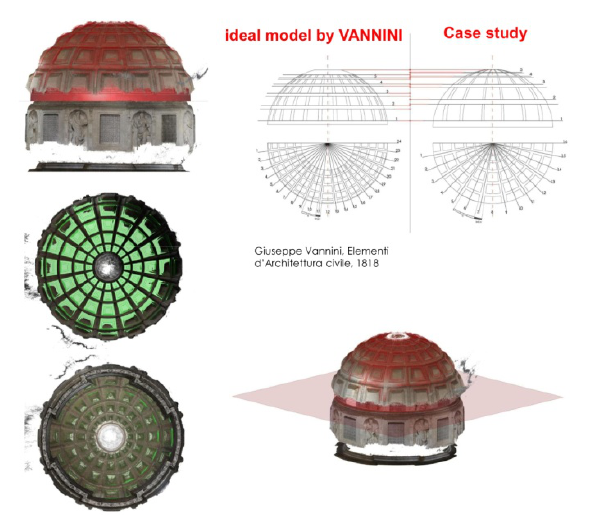
Figure 6. Coffers distribution rules on hemispherical domes by Giuseppe Vannini. Generative model.